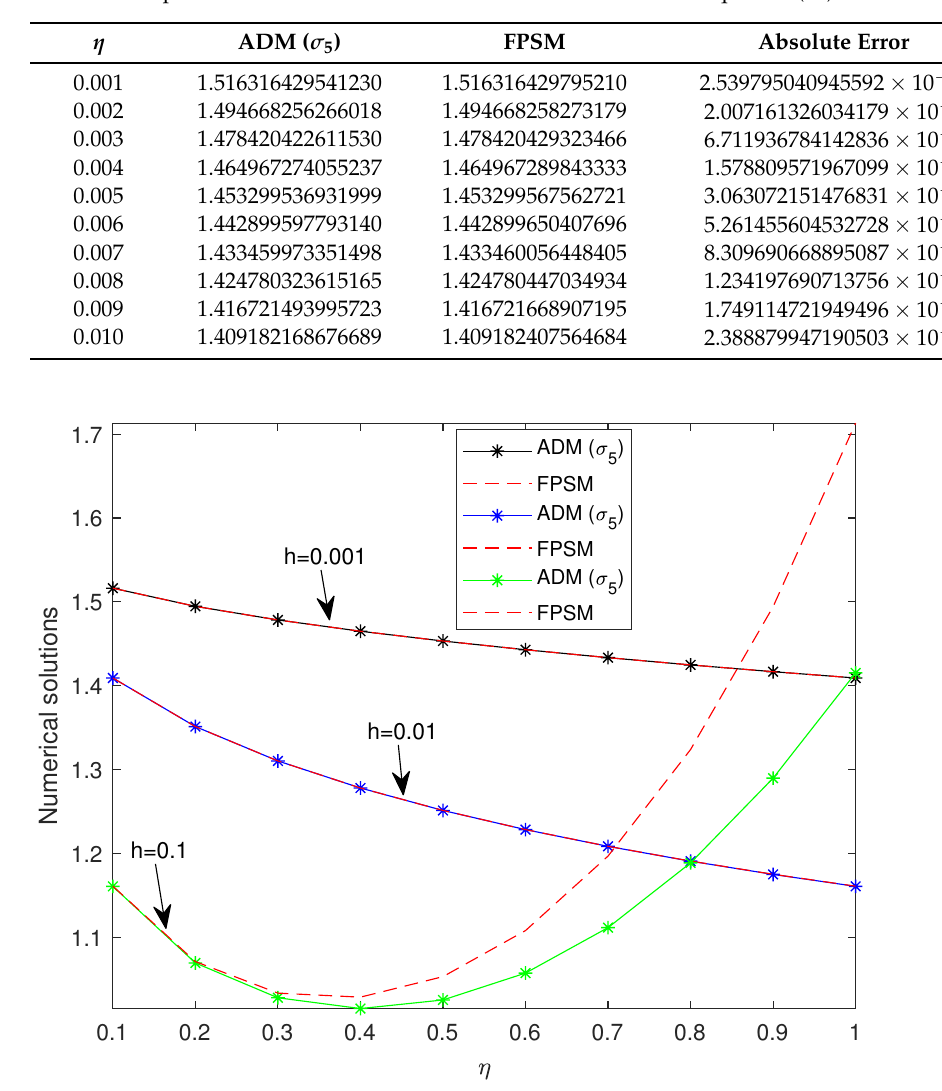
Figure 4. The ADM ( σ 5 ) and FPSM solutions of Equation (35), Υ ( η ) vs η , for h = { 0.1,0.01,0.001 }